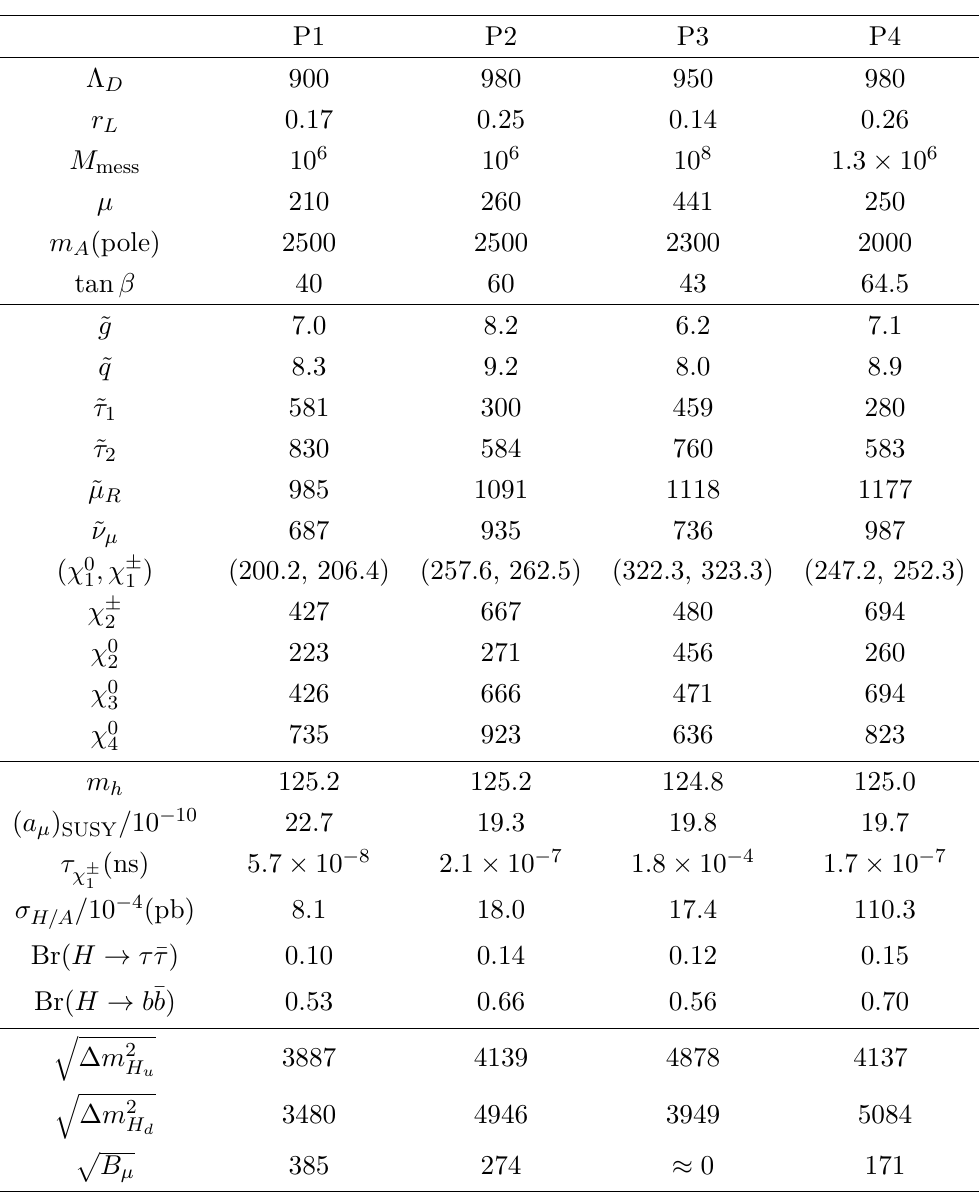
Table 1 . The mass spectra and ( a µ ) SUSY . The (lightest) squark and gluino masses as well as Λ D are shown in units of TeV while the others are shown in units of GeV. We also show q ∆ m 2 and p B at the messenger µ H d